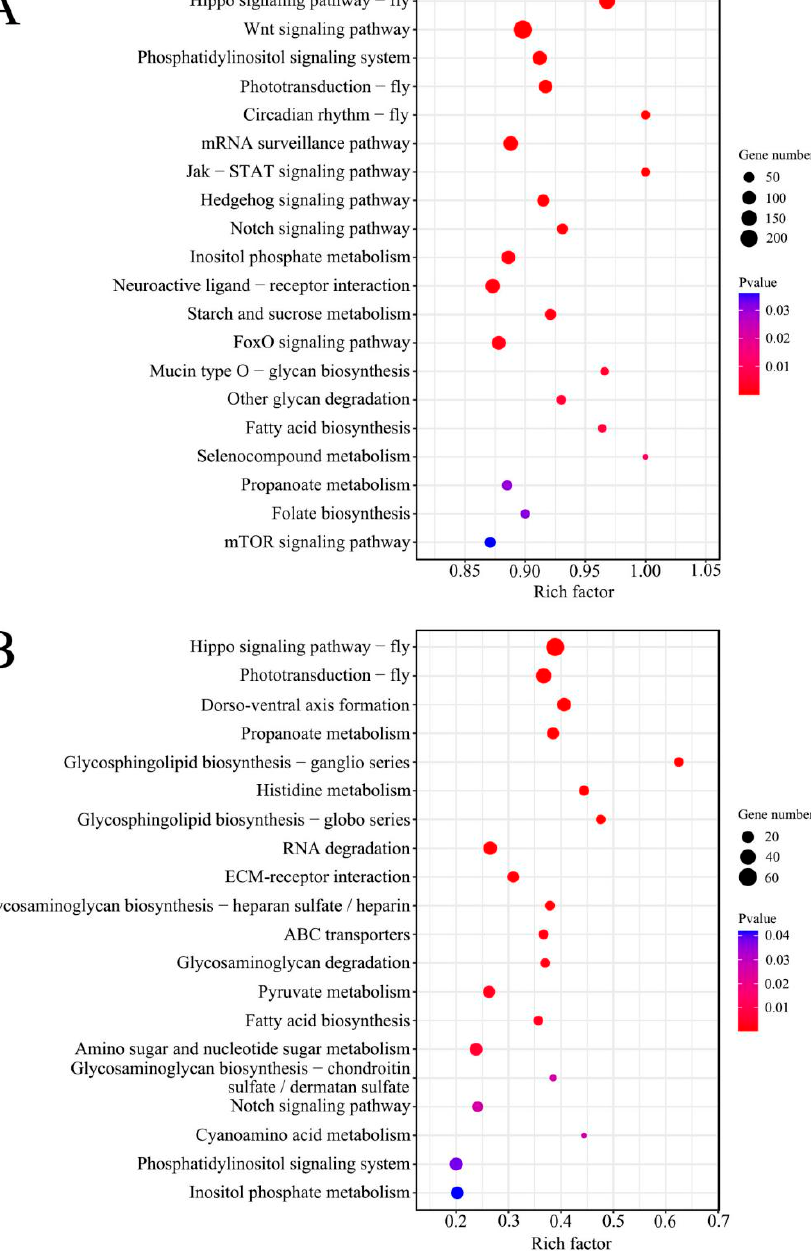
Figure 4. Top 20 KEGG pathways that were annotated by target genes of DEpiRNAs in the “Am4 vs. Am5” ( A ) and “Am5 vs. Am6” ( B ) comparison groups. Circle size increases with the number of target genes, circle color depth increases significantly with p -value.